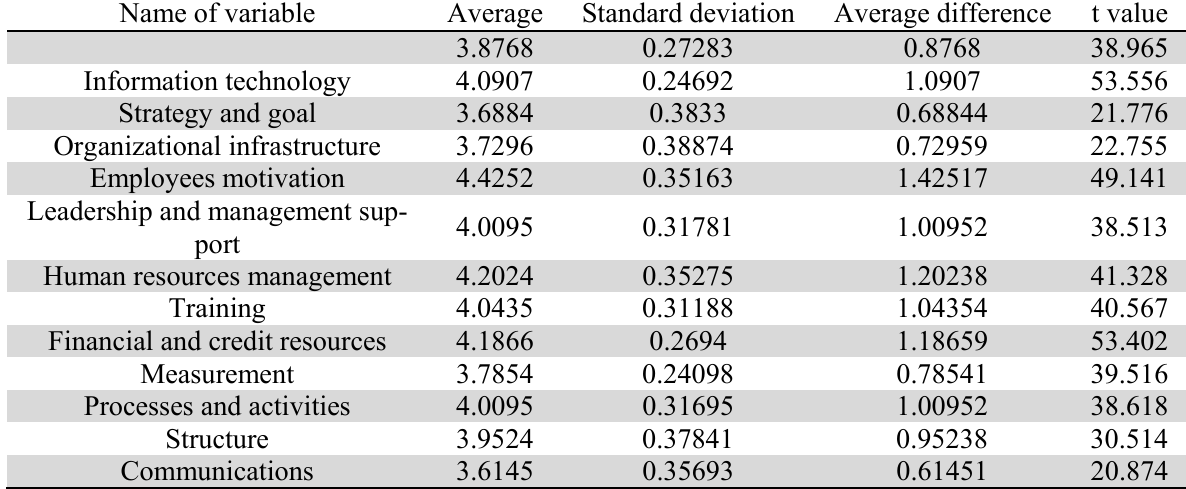
Table of comparison of the studied variables (with an average of 3 based on 5 point Likert scale)